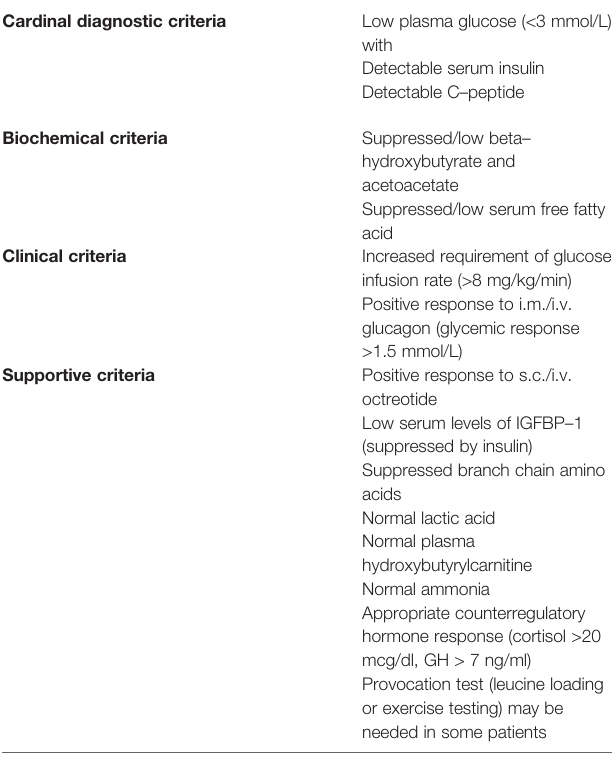
TABLE 5 | Diagnostic criteria of